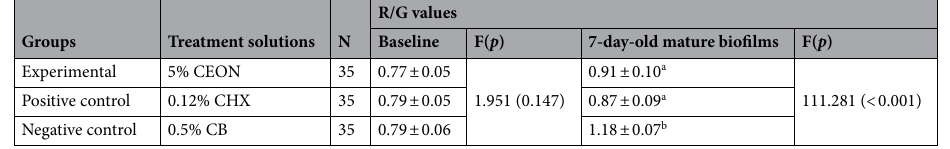
Table 1. R/G values of 7-day-old mature biofilms according to treatment solution. CEON cinnamon essential oil nanoemulsion, CHX chlorhexidine gluconate, CB cocamidopropyl betaine. p values obtained from one- way analysis of variance. All values are expressed as means ± standard deviations. a, b Different letters indicate significance by Bonferroni multiple comparison test at α = 0.05.